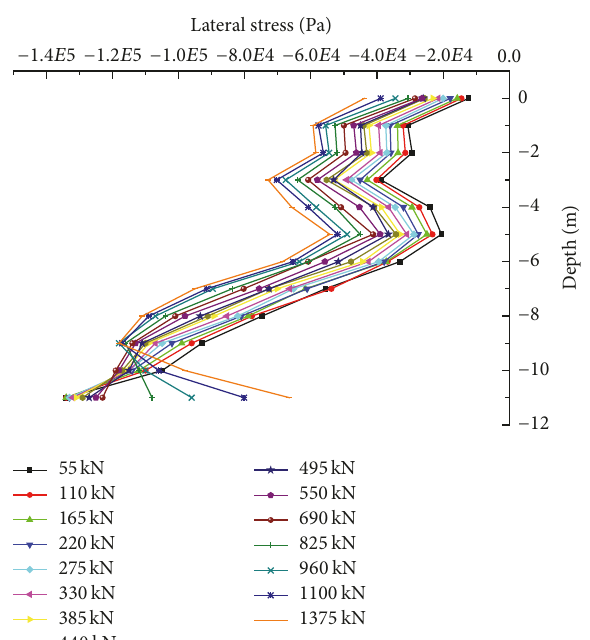
Figure 3: Variation in lateral stress along the depth of the pile.